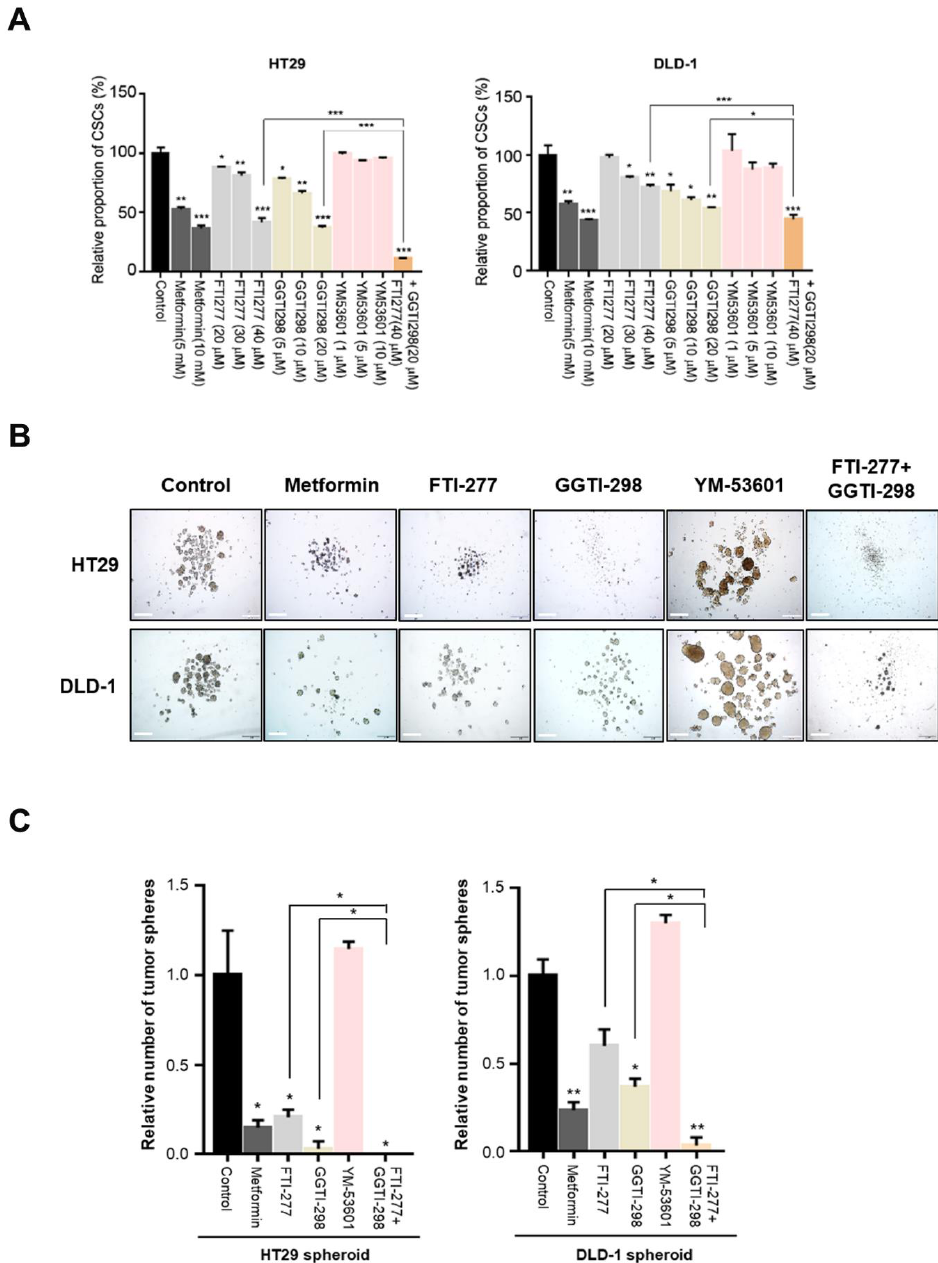
Figure 3. Cancer stem cell proportion was reduced by inhibition of protein prenylation, but not by inhibition of squalene synthase in the mevalonate pathway. ( A ) HT29 and DLD-1 cells were treated with metformin (5 or 10 mM), farnesyltransferase inhibitor (FTI-277; 20, 30, or 40 µ M), geranylgeranyl transferase I inhibitor (GGTI-298; 5, 10, or 20 µ M), or squalene synthase inhibitor (YM-53601; 1, 5, or 10 µ M) for 48 h, and then the CD44 +/ CD133 + population was analyzed by flow cytometry using anti-CD44-FITC and anti-CD133-PE. ( B , C ) In tumor sphere cultures treated with metformin (10 mM), FTI-277 (40 µ M), GGTI-298 (20 µ M), or YM-53601 (10 µ M) for 5 days, the number of tumor spheres ( ≥ 200 µ m in diameter) was counted and compared to the counts in control cultures. Magnification, 40 × . Data are expressed as the mean ± standard error of three independent experiments; * p < 0.05, ** p < 0.01, and *** p < 0.001 (compared with